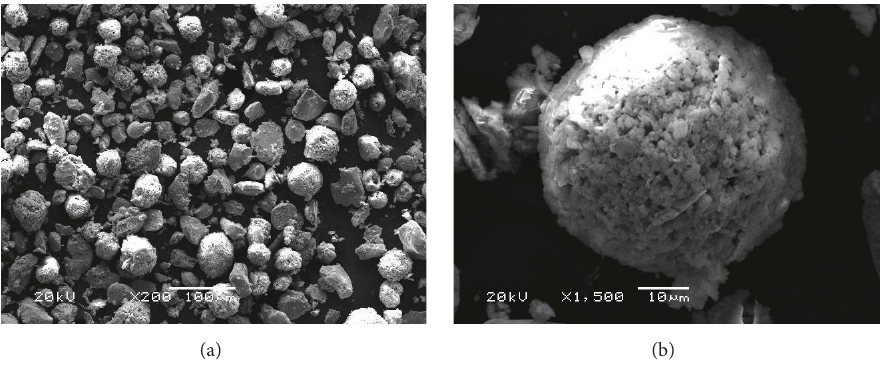
Figure 1: Morphologies of the composite powders. (a) Agglomerated powders; (b) a particle of the agglomerated powders.